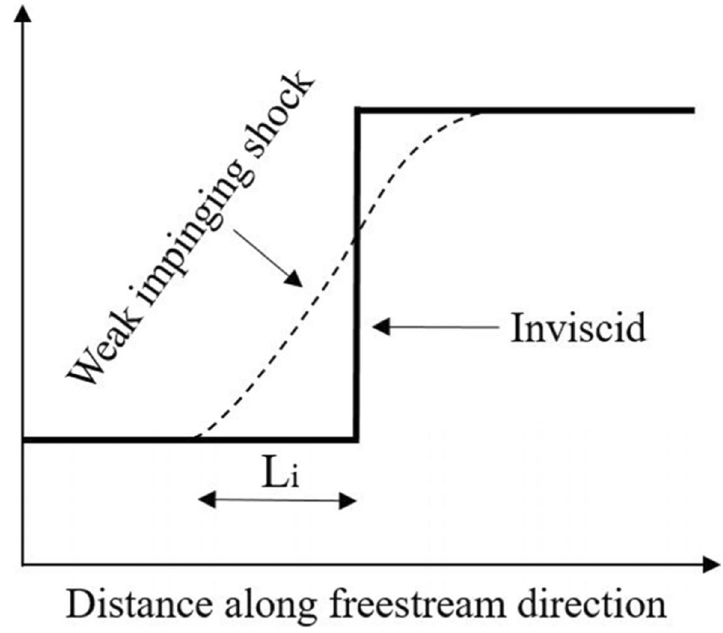
Fig. 2 Wall static pressure distribution for a weak SBLI